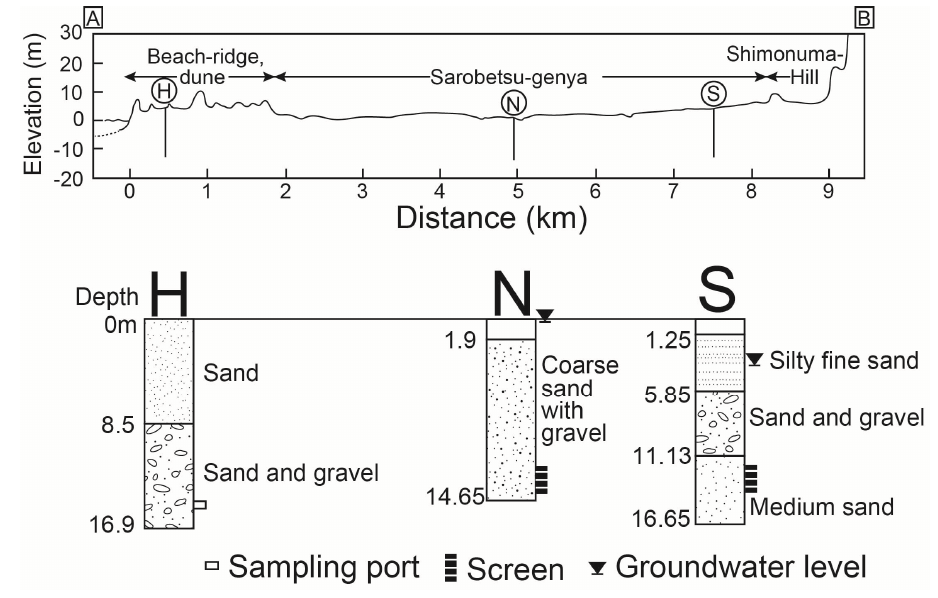
Figure 2. Topographical transects, stratigraphic profiles at piezometer locations, depths of piezometer screens, and groundwater levels. No data at site H. (data from